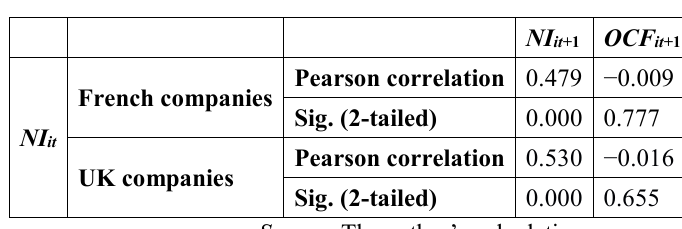
Table 2. The Results of the Correlation between Variables